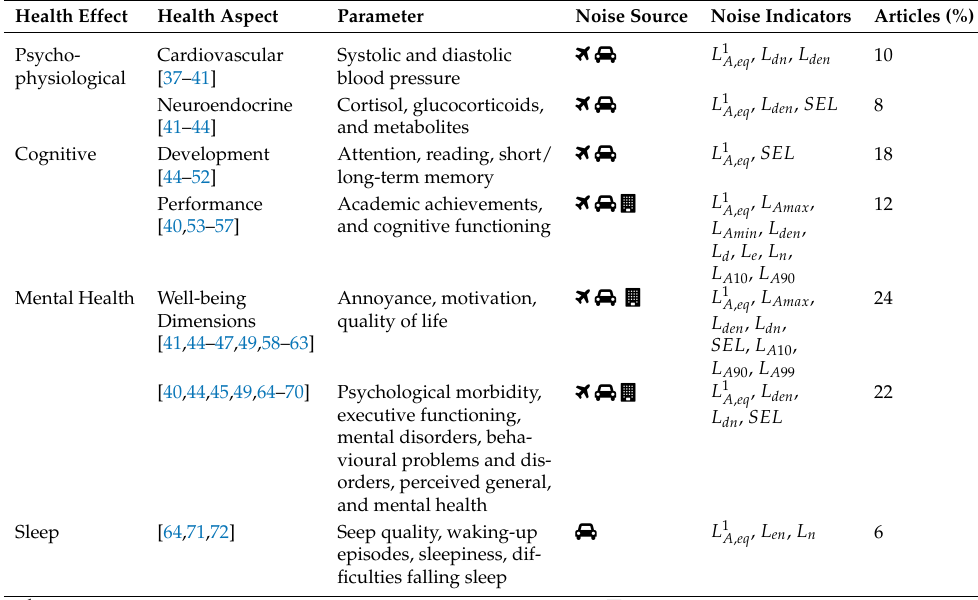
Table 4. Overview of the collected information extracted from the included literature.